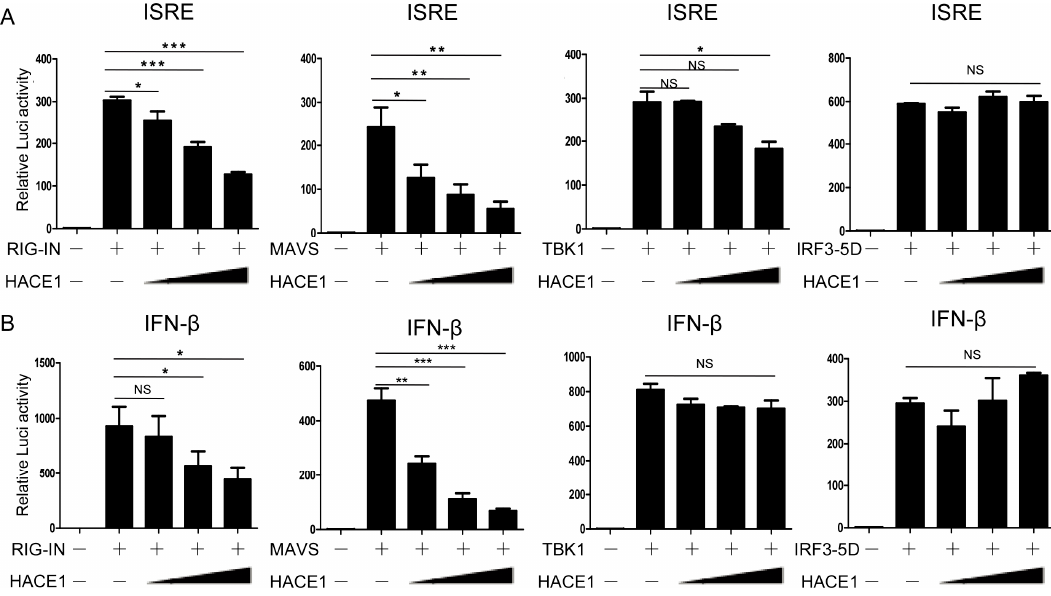
Figure 4. HACE1 targets downstream of MAVS and upstream of TBK1. ( A ) Effects of HACE1 on ISRE activation by various signaling components in a dose-dependent manner; ( B ) effects of HACE1 on IFN- β activation by various signaling components in a dose-dependent manner. HEK293T cells were seeded on 24-well plates and transfected the next day with indicated signaling molecules, IFN- β or ISRE luciferase reporter and pRL-SV40 plasmid and increasing doses of HACE1 for 24 h. The luciferase activities were quantified by normalizing with Renilla luciferase activities. Data are representative of at least three independent experiments. * p < 0.05; ** p < 0.01; *** p < 0.001.